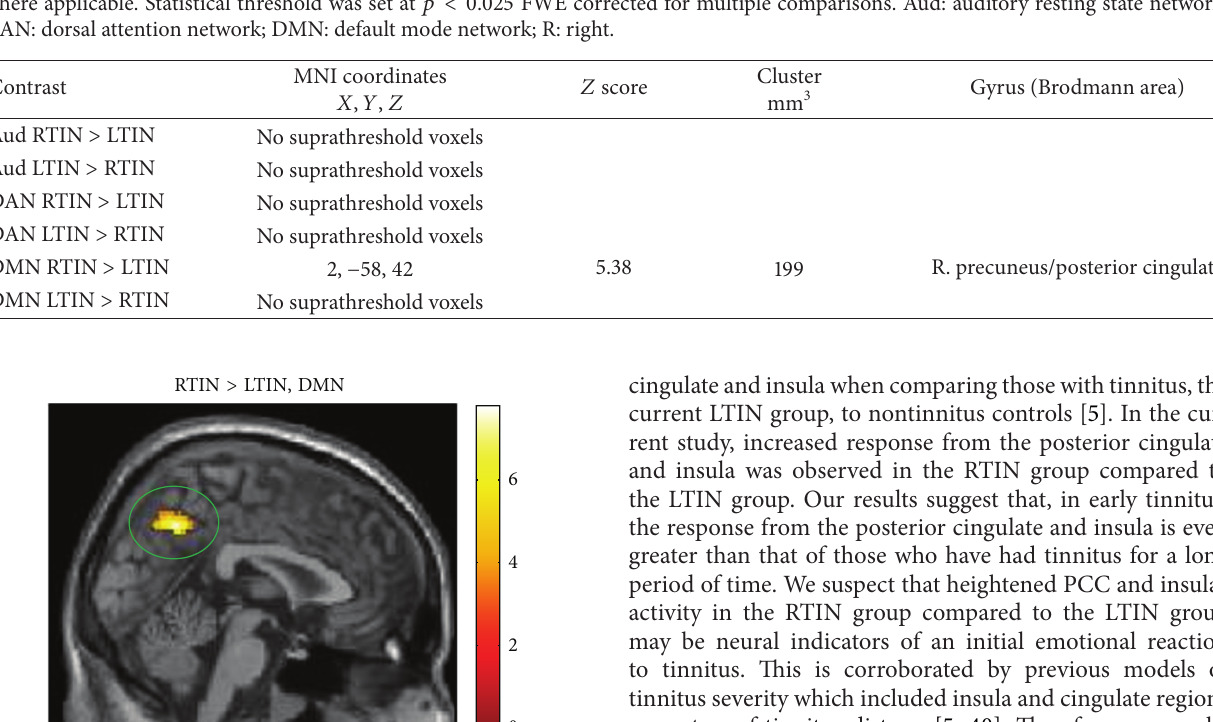
Table 7: Regions of significance in the resting state connectivity analysis. Between-group independent sample 𝑡 -tests were performed for each resting state network examined. Regions are listed in Montreal Neurological Institute (MNI) coordinates. Brodmann areas are also provided where applicable. Statistical threshold was set at 𝑝 < 0.025 FWE corrected for multiple comparisons. Aud: auditory resting state network;